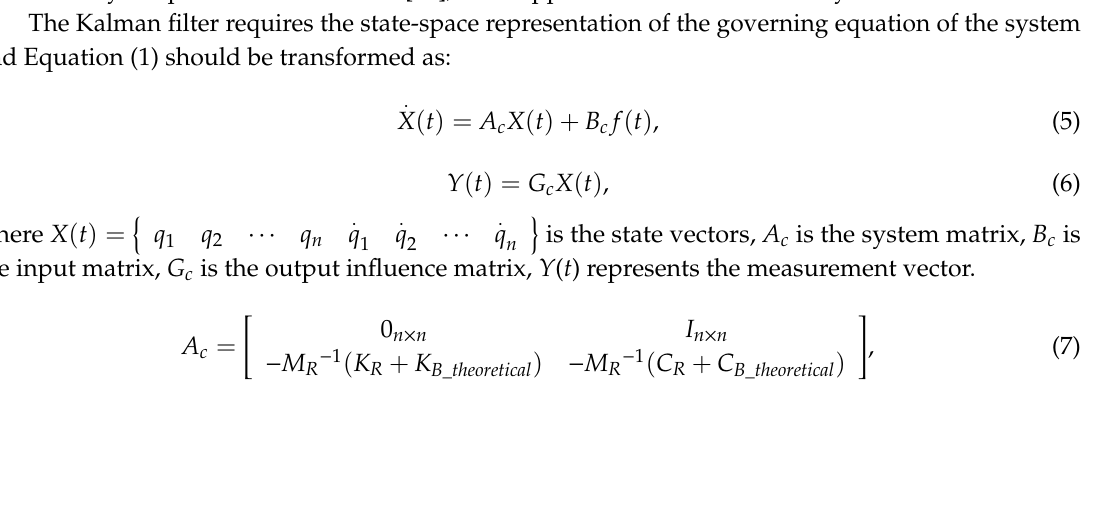
Figure 4. Flowchart of the proposed method.